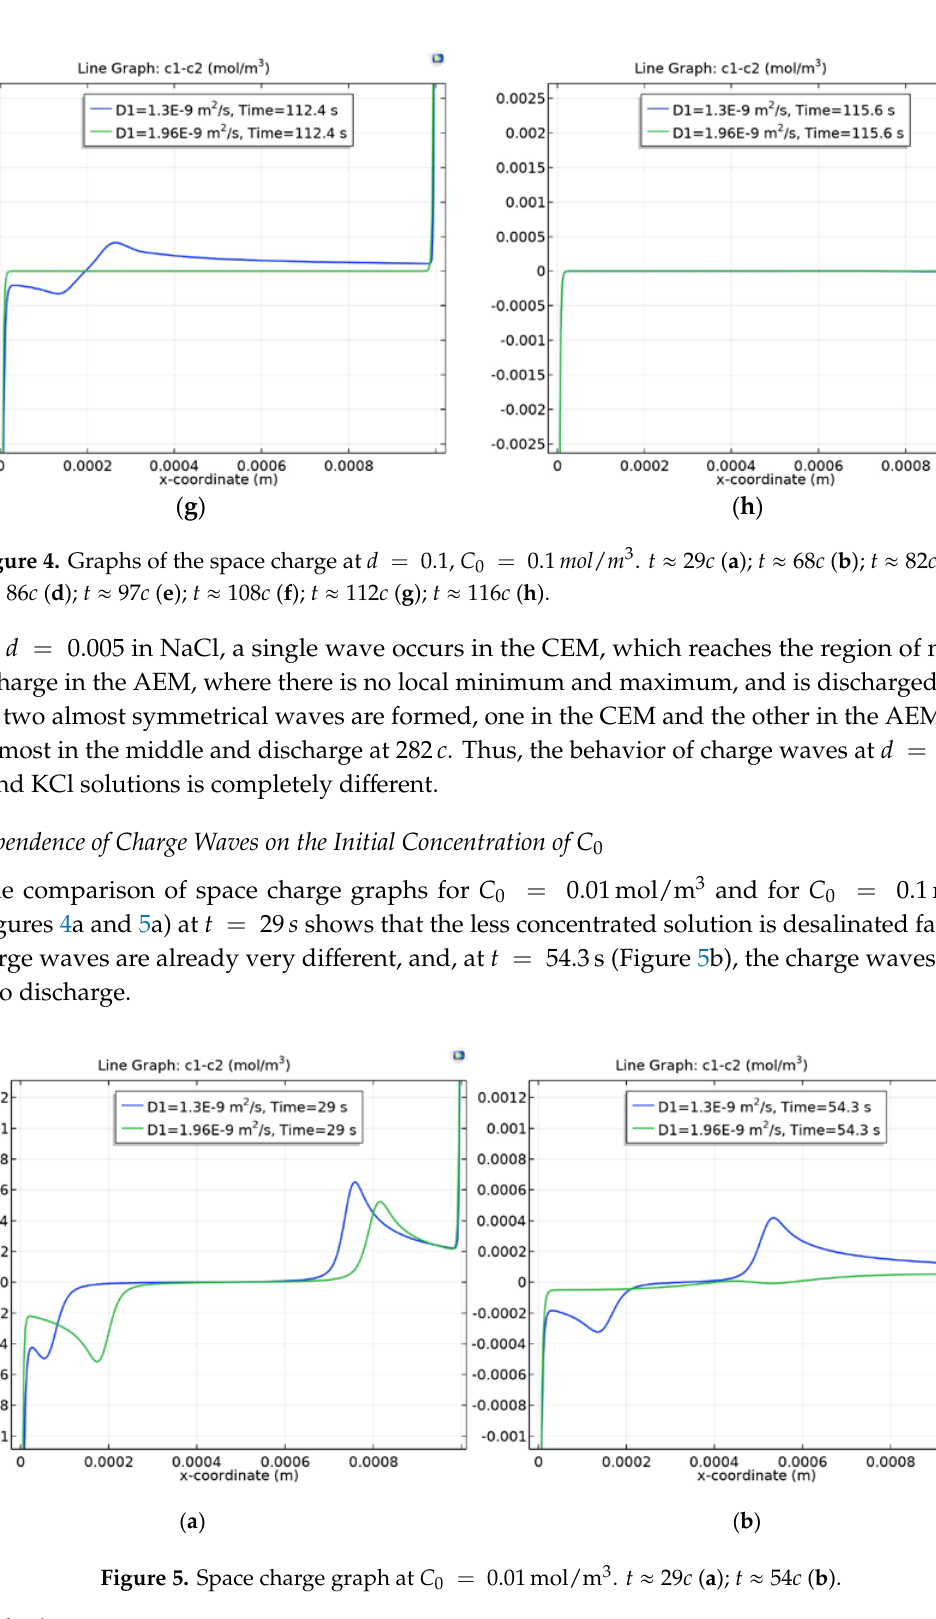
Figure 5. Space charge graph at C 0 = 0.01mol/m 3 . t ≈ 29 c ( a ); t ≈ 54 c ( b )